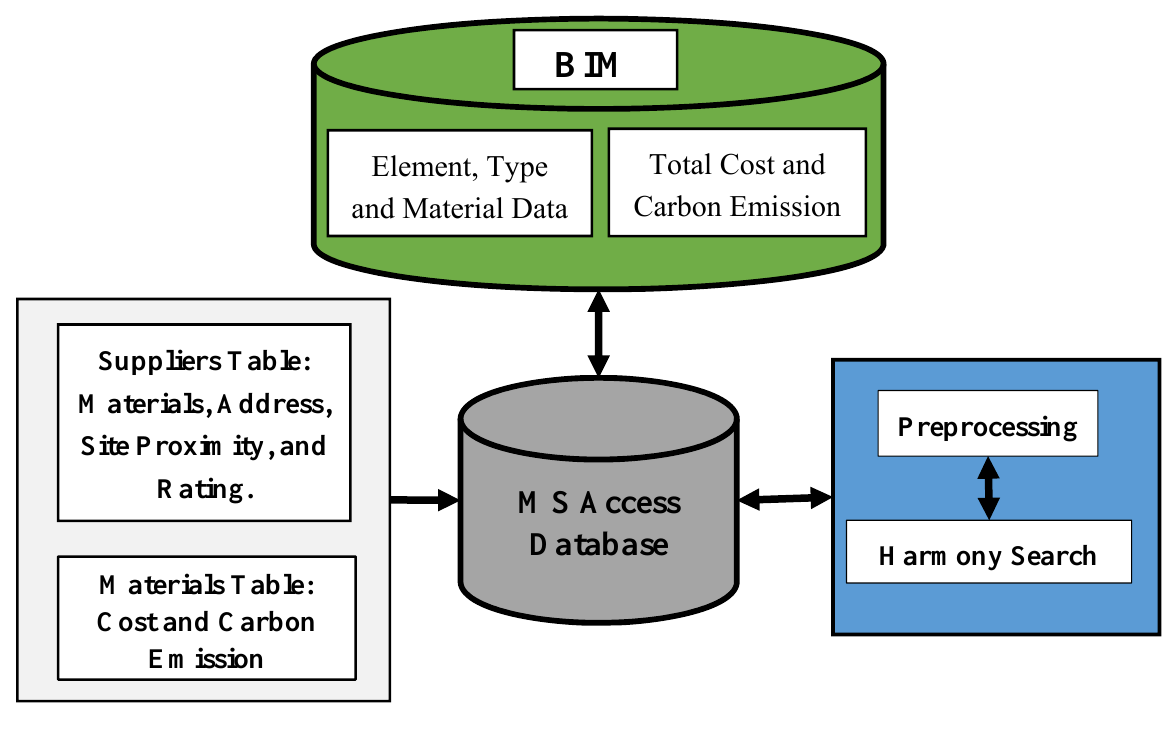
Figure 1. System architecture for material